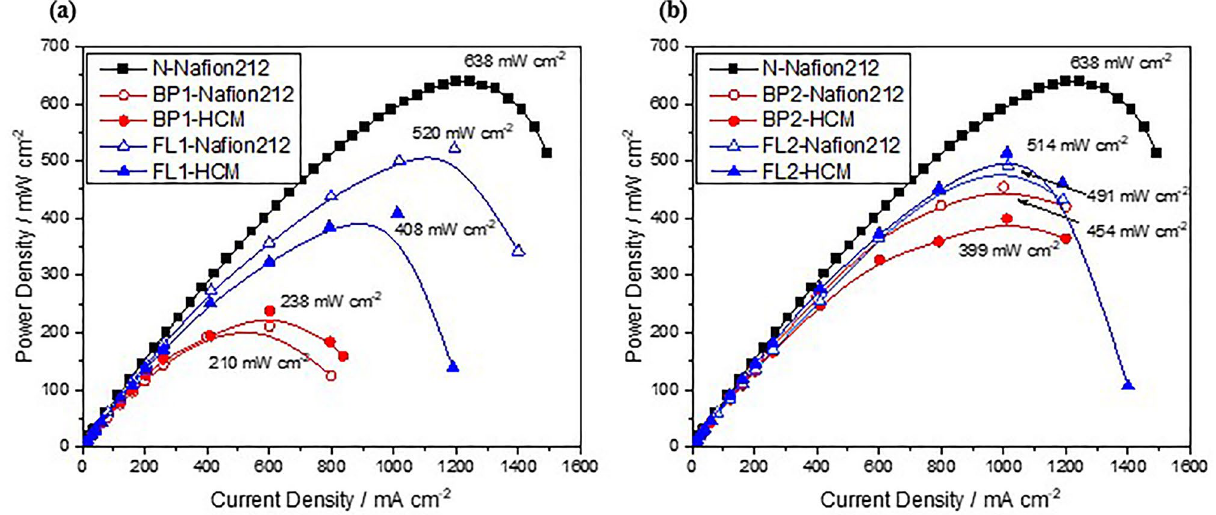
Figure 3. Power densities of the MEAs prepared with ( a ) BP1 and FL1 and ( b ) BP2 and FL2 as cathodic binders compared to the Nafion ionomer at a cell temperature of 80 °C and RH of 100%. N represents the Nafion ionomer of EW1100. BP1 and BP2 indicate the SPES synthesized by biphenyl groups with IECs of 1.22 and 1.56 meq g –1 , respectively. Similarly, FL1 and FL2 indicate the SPES synthesized by fluorenyl groups with IECs of 1.31 and 1.45 meq g –1 , respectively. The ion exchange membrane were Nafion 212 and HCM. HCM indicates a typical SPES hydrocarbon membrane with a 50% degree of sulfonation synthesized by biphenyl groups. N-Nafion212 denotes a Nafion ionomer as a cathodic binder combined with a Nafion212